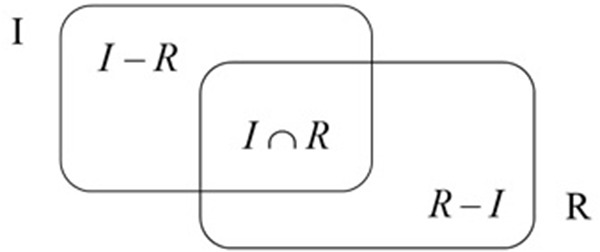
The relation between two sets of features (Tversky, 1977).